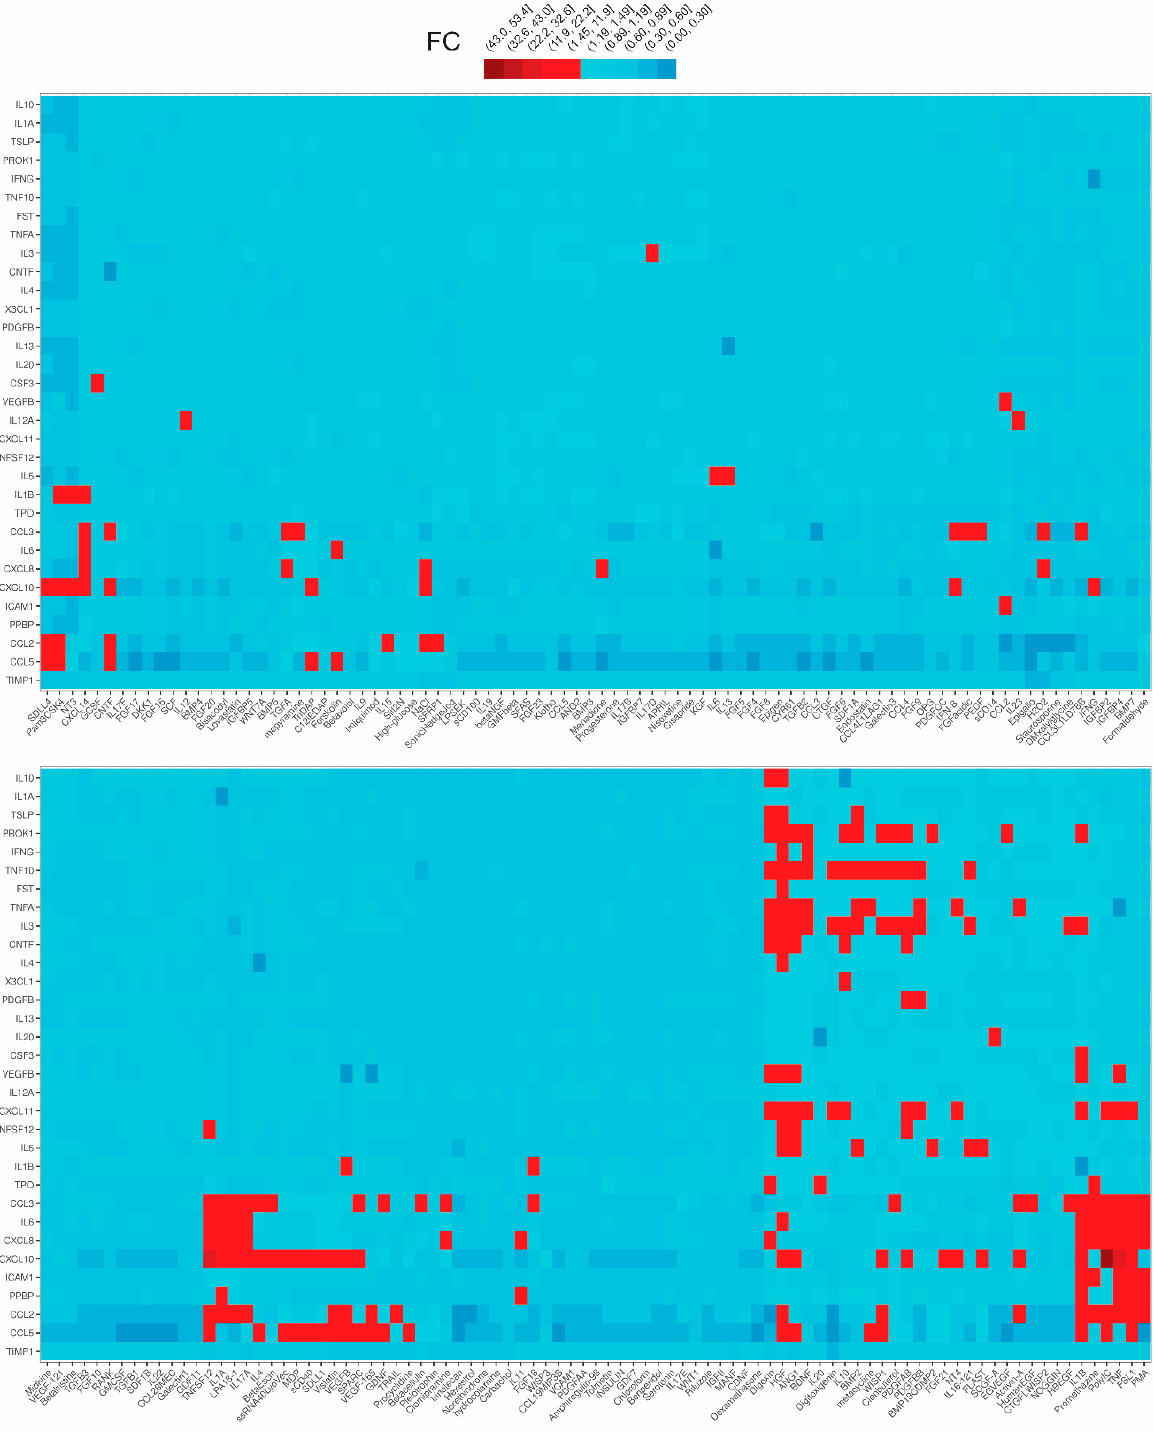
Figure 2. Differential expression of 32 secreted biological factors in the supernatants of human kidney proximal tubular epithelial cells (HKC-8) upon the stimulation with LPA (18:1) and 175 disparate biological stimuli. The expression was assessed with multiplex ELISA employing microbeads of unique spectral signatures conjugated with monoclonal antibodies specific for each of the 32 secreted factors. Red indicates active signals (FC ≥ 1.5). See also Figure S1.